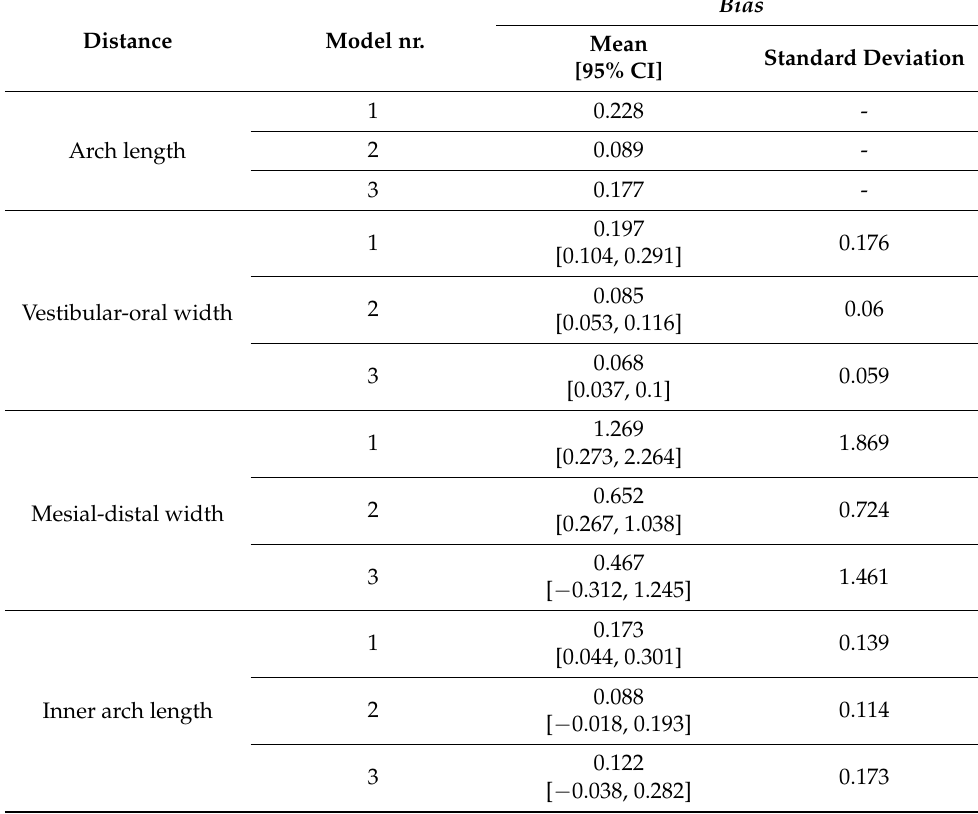
Table 1. Descriptive statistical indicators of the characteristics for the three models.